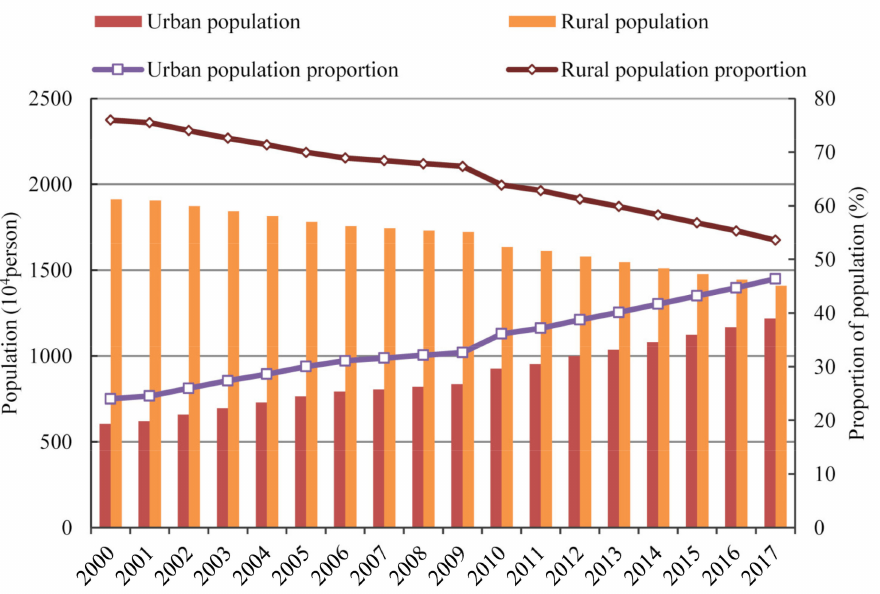
Figure 7. Changes in the number and the proportion of urban and rural population in Gansu Province from 2000 to